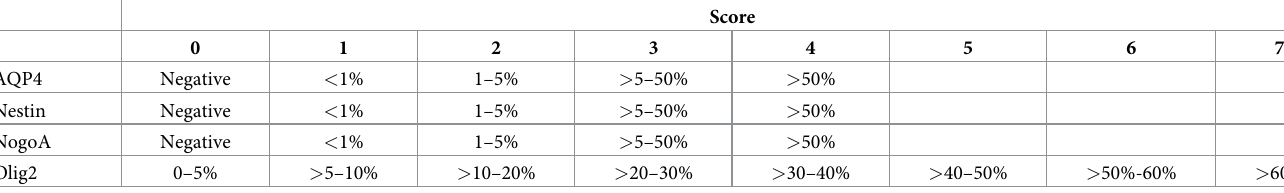
Table 2. Scoring system for immunohistochemical